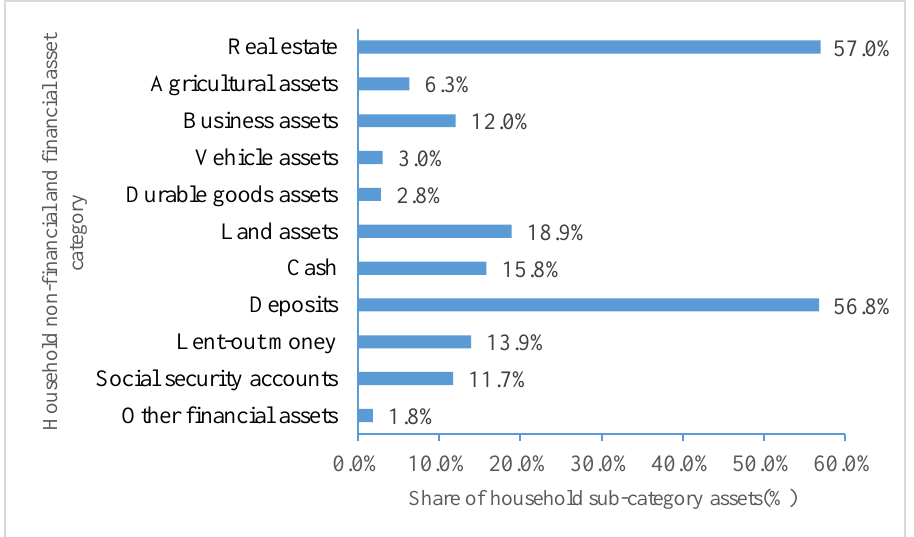
Figure 2. The share of household subcategory assets. Source: Report on the Development of Household Finance in Rural China, 2014. Note: The shares of real estate, agricultural assets, business assets, vehicle assets, durable goods assets and land assets were the corresponding proportions in non-financial assets. Similarly, the shares of cash, deposits, lent-out money, social security accounts, and other financial assets were also the corresponding proportions in financial